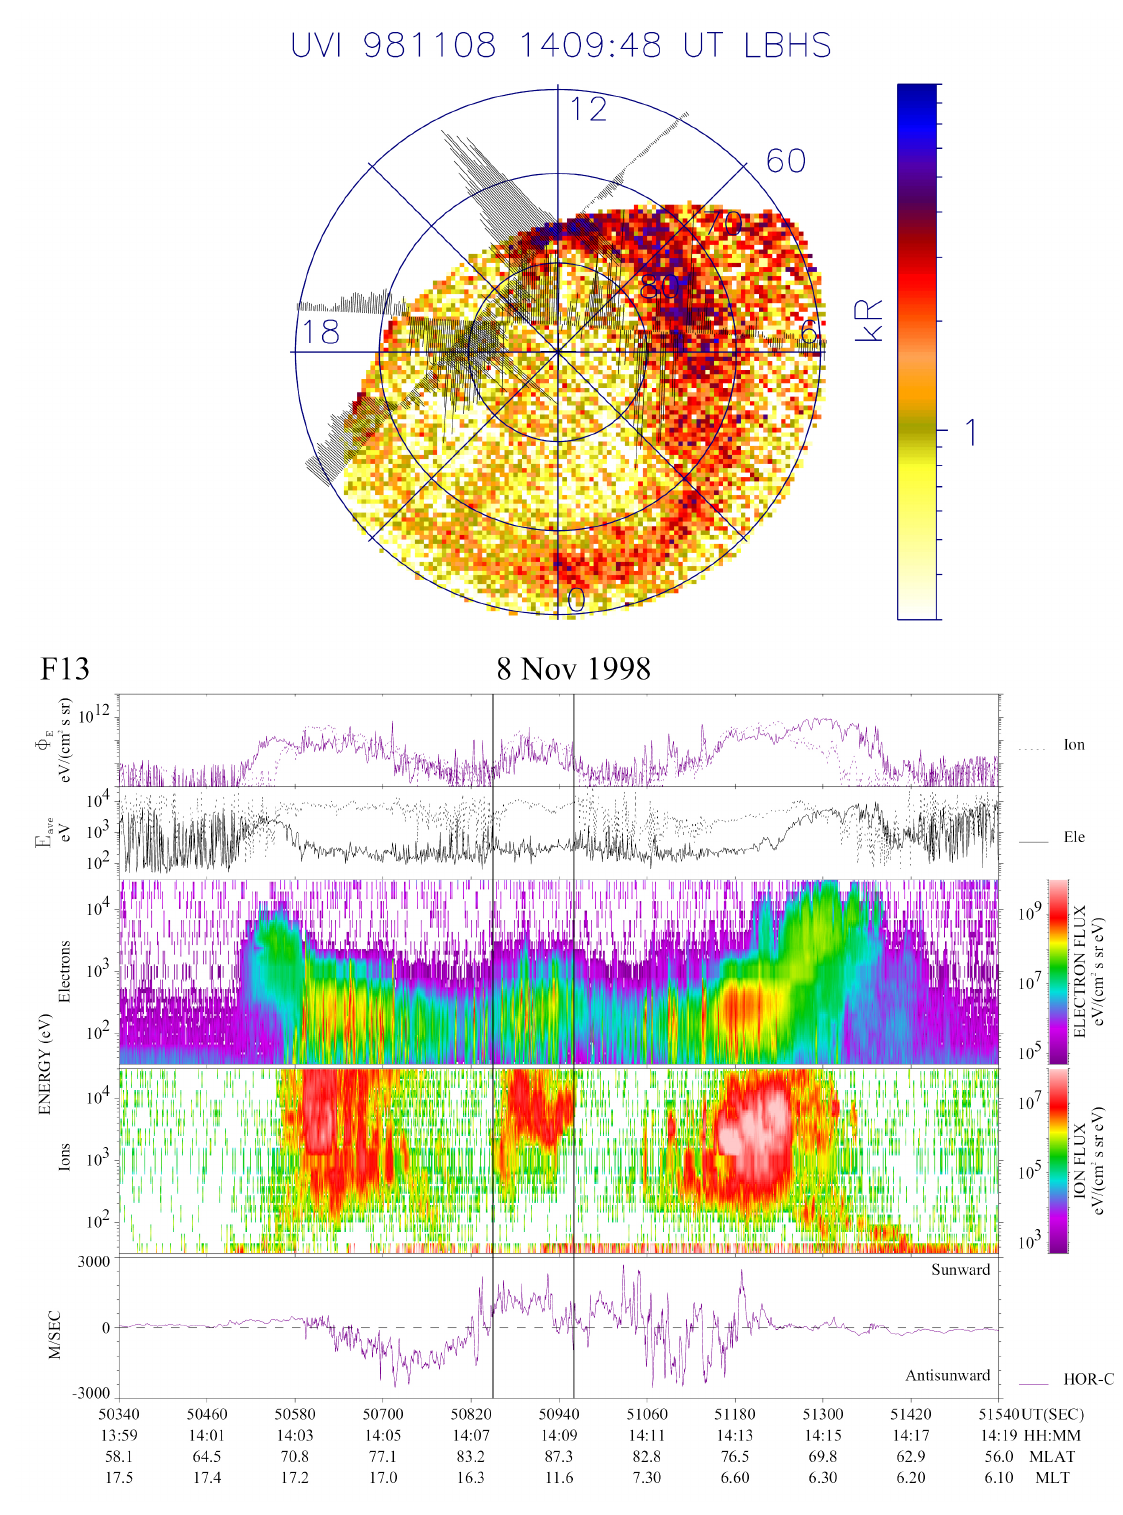
Fig. 5. Data shown from the second DMSP pass on 8 November 1998 (13:59–14:19 UT) that occurs during the UVI data period. Same format as Fig. 4. See text for